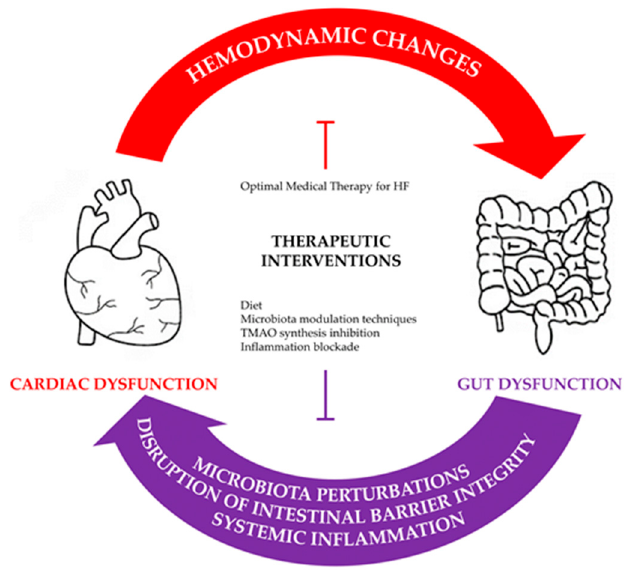
Figure 1. The gut–heart axis and its potential therapeutic targets